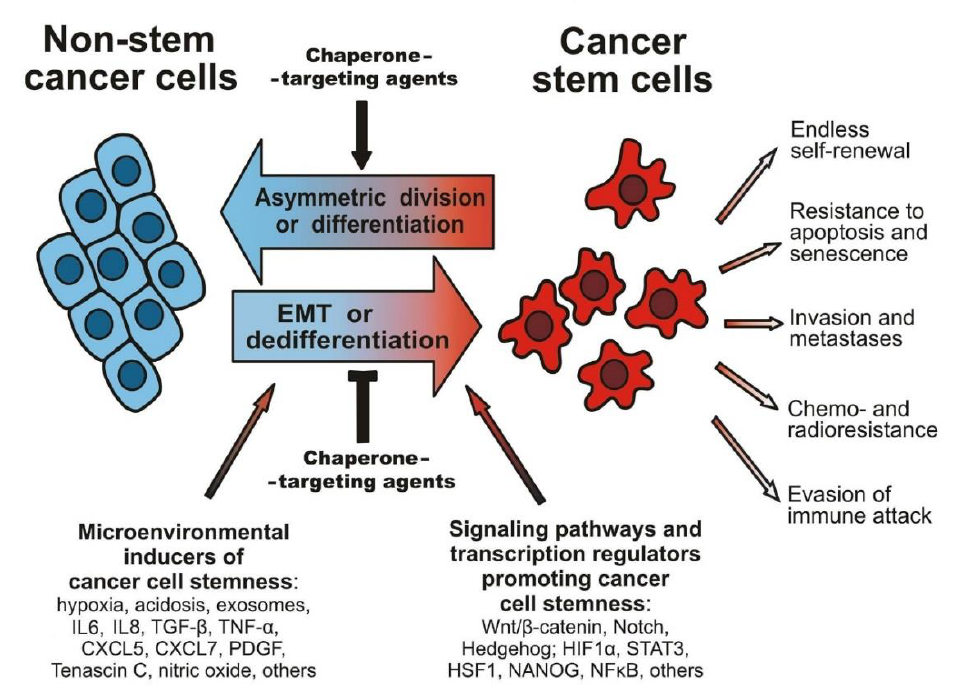
Figure 1. Aschemeillustratingtheplasticityofcancercellphenotypesandreversibletransitionsbetweenthe pools of non-stem cancer cells and CSCs. The figure includes extracellular and intracellular stimuli, factors, and pathways that can contribute to the cancer stemness development, and also shows the characteristic CSC properties that are critical for the tumorigenicity and cancer pathogenesis. Potential opportunities for chaperone-targeting agents are here indicated by black arrows (see details in the